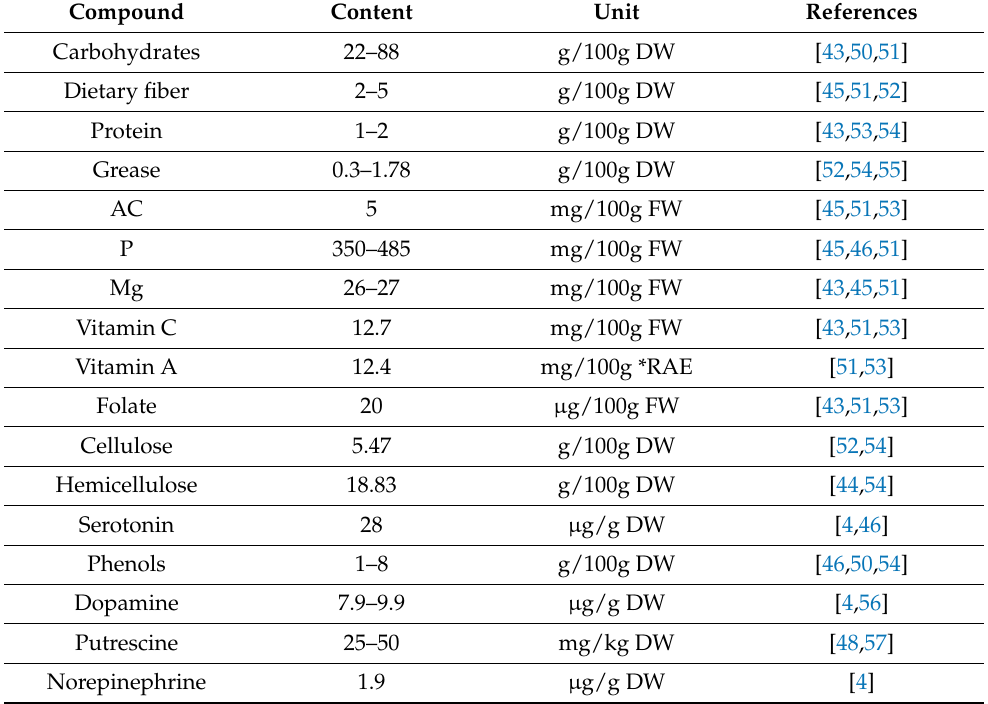
Table 2. Chemical composition of Banana